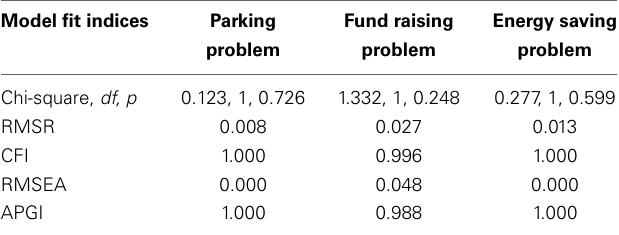
Table 4 | Fit for the path analysis model in the three decision problems.